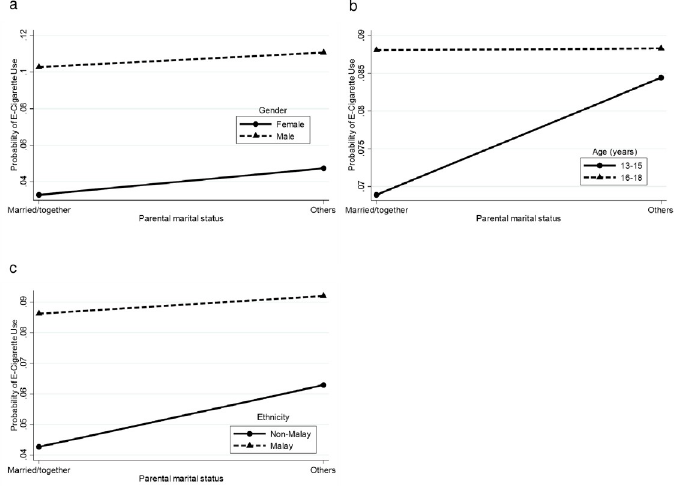
Fig 6. Probability of current e-cigarette use. (a) Parental marital status-gender: married and living together (male = 10.3%, female = 3.3%), others (male = 11.1%, female = 4.7%). (b) Parental marital status-age: married and living together (13–15 = 6.9%, 16–18 = 8.8%), others (13–15 = 8.4%, 16–18 = 8.8%). (c) Parental marital status- ethnicity: married and living together (non-Malay = 4.3%, Malay = 8.6%), others (non-Malay = 6.3%, Malay = 9.2%).